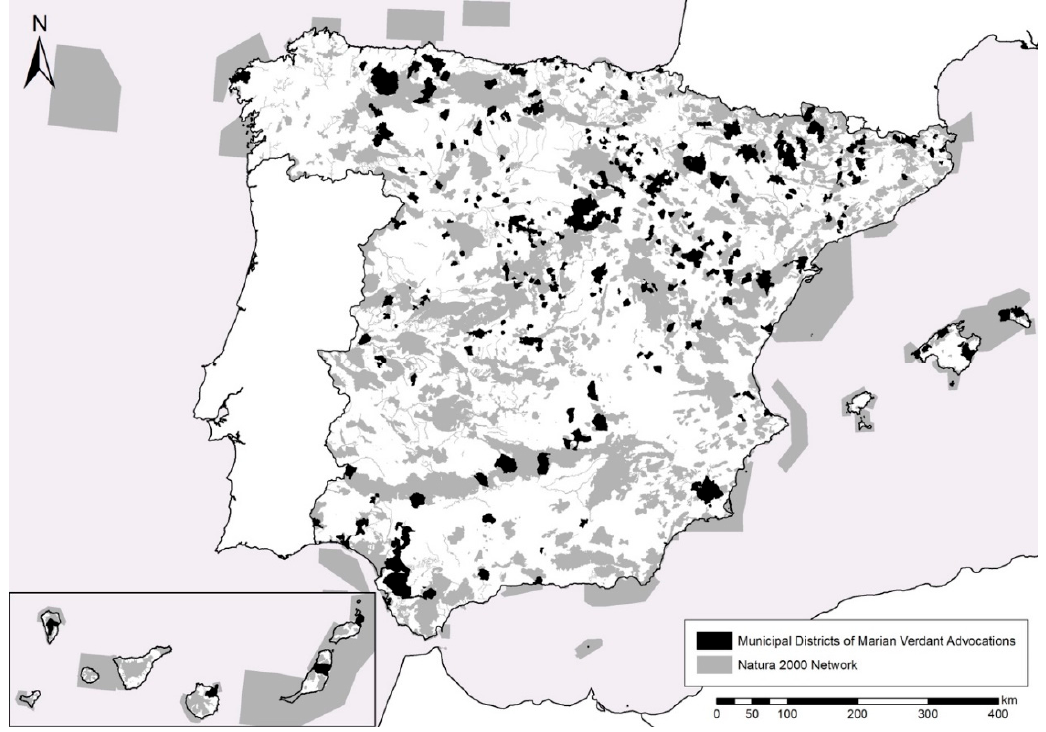
Figure 1. Municipal districts with Marian verdant advocations in Spain.